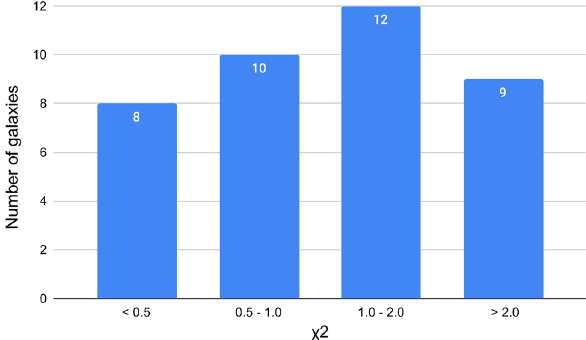
Fig. 11 The distribution of the χ 2 values, describing the accuracy of the fitting of the rotation curves for the full set of 39 considered galaxies for a fixed static radius R = 16 kpc